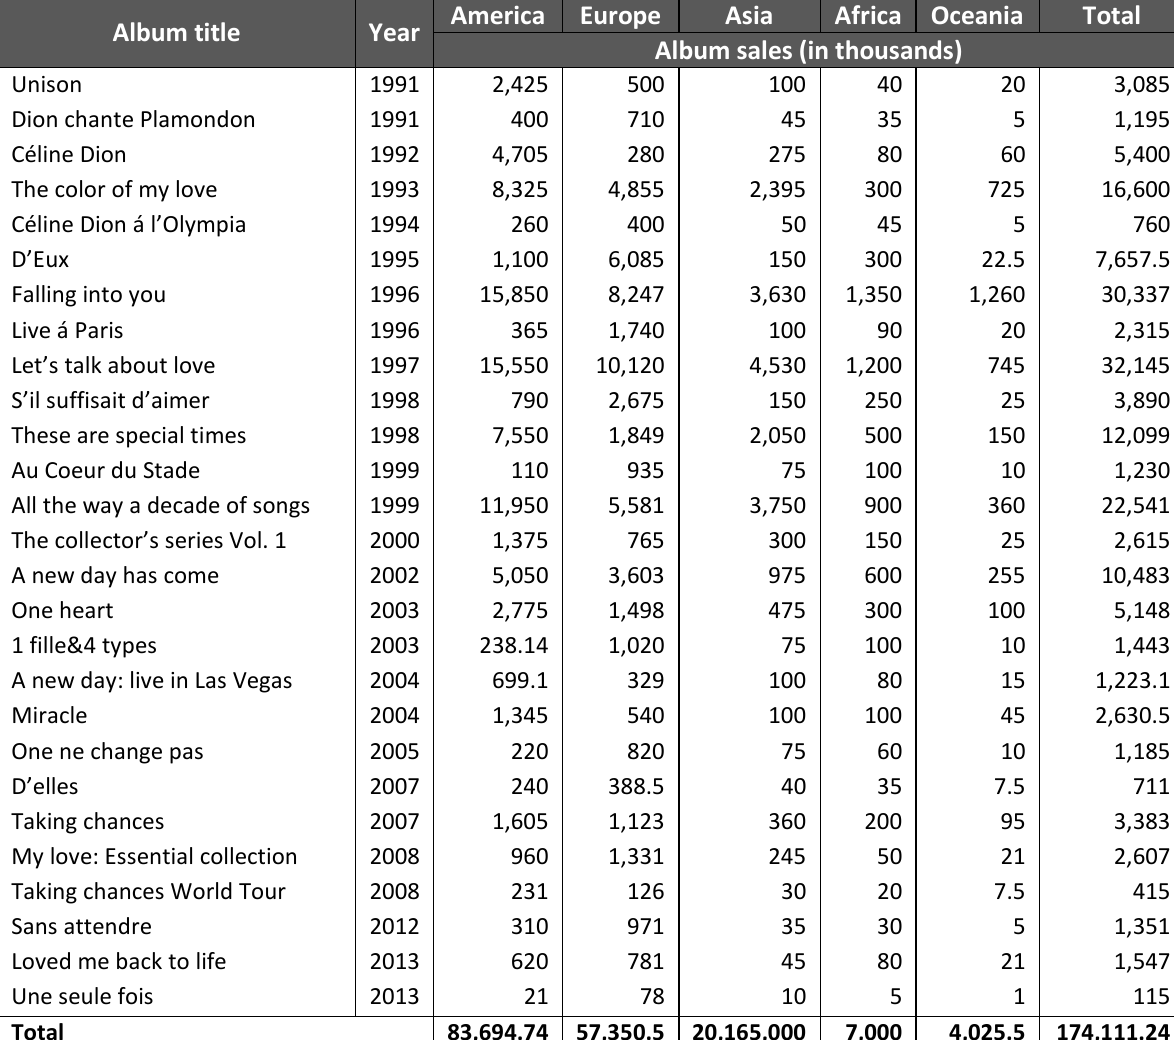
Table 3: Statistics on album sales per continent 1991 –